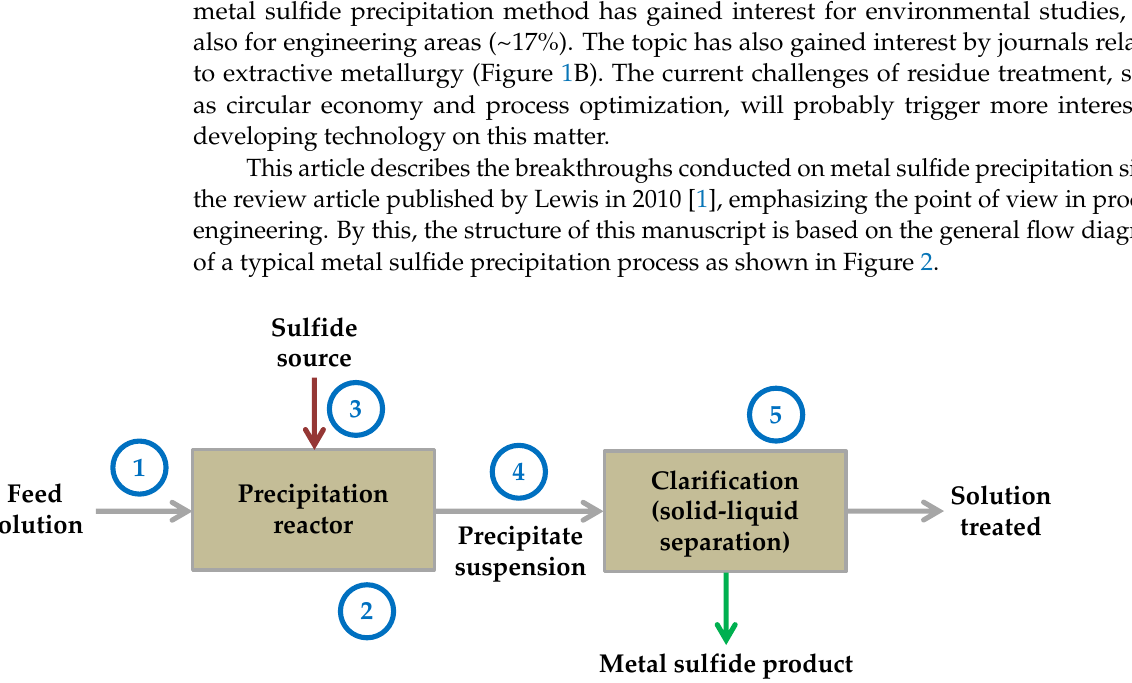
Figure 2. Schematic representation of the flow diagram of a typical metal sulfide precipitation process. Numbers are related to the focus of the studies reviewed here.